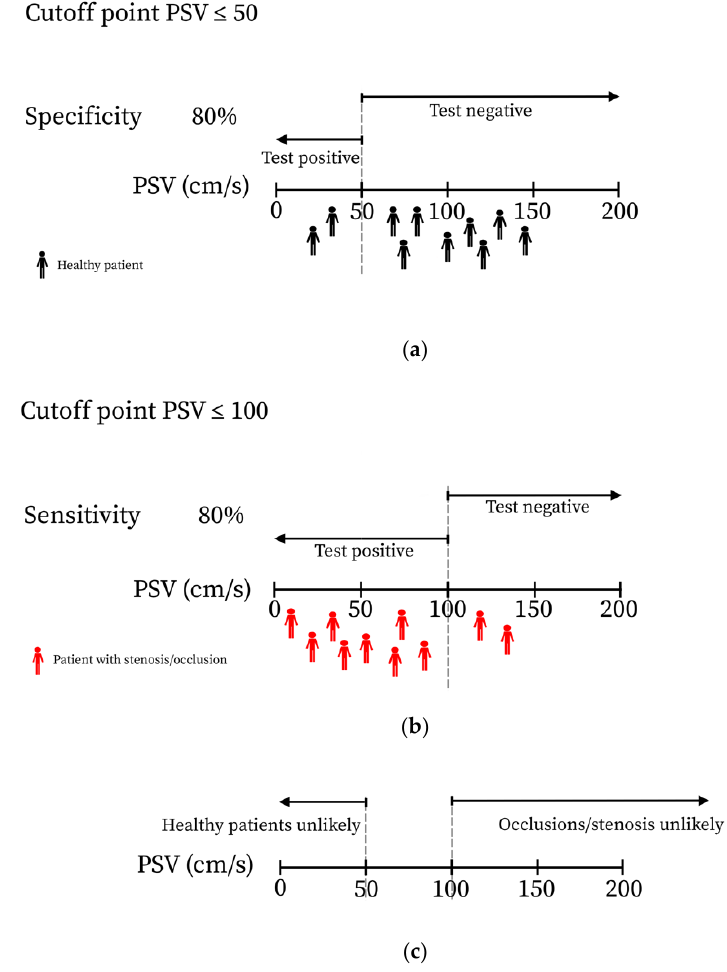
Figure 2. Illustration of the meaning of a high specificity and sensitivity for the selected cutoff points. ( a ) Illustrates that in 80% of all healthy patients, a peak systolic velocity (PSV) value of > 50 cm / s was found. ( b ) Illustrates that in 80% of the patients with an occlusion or stenosis, a PSV ≤ 100 cm / s was found. ( c ) Illustrates that taking into account figures ( a , b ), this means that if in a patient a PSV value ≤ 50 is found, it is unlikely that the patient is healthy and if in a patient a PSV value of > 100 cm / s is found, the patient is unlikely to have an occlusion or stenosis.